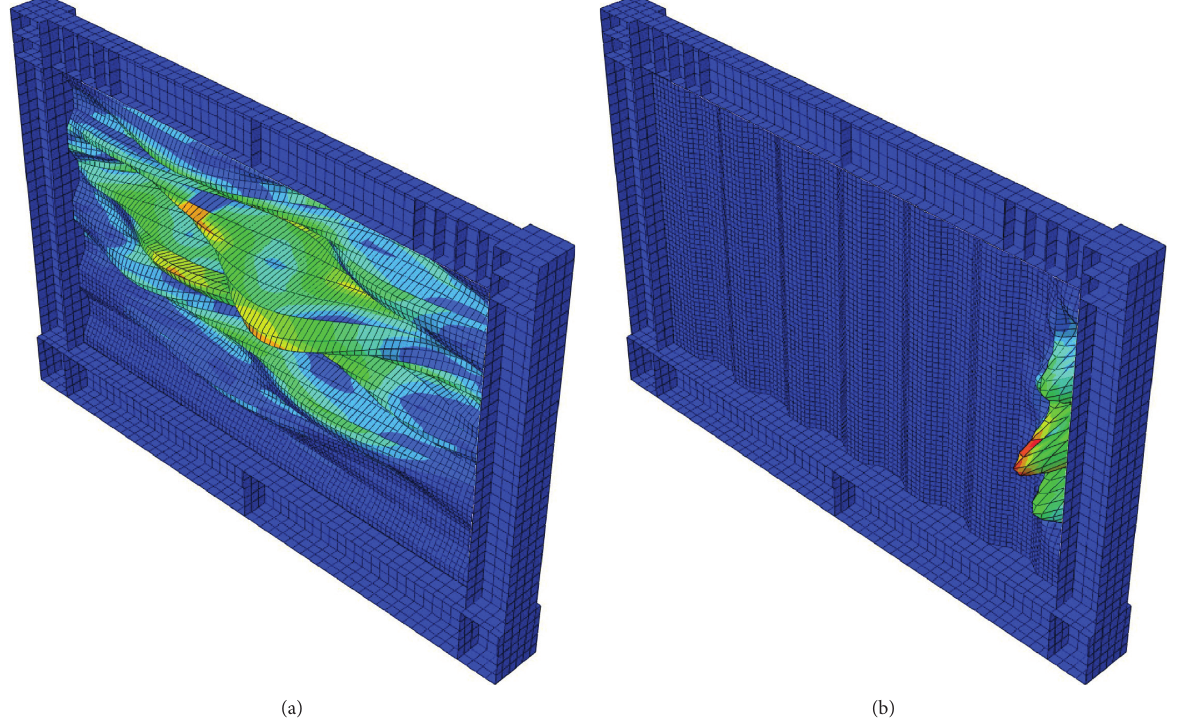
Figure 4: First mode shape of CSPSWs in the fully connected state. (a) Horizontal CSPSW. (b) Vertical CSPSW.